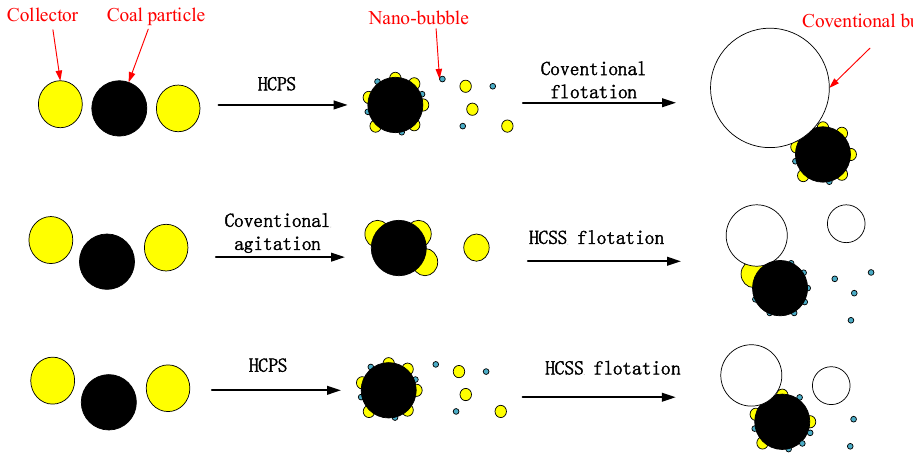
Figure 13. Schematic diagram of the flotation enhancement of HCCS, HCSS, and HCWS.